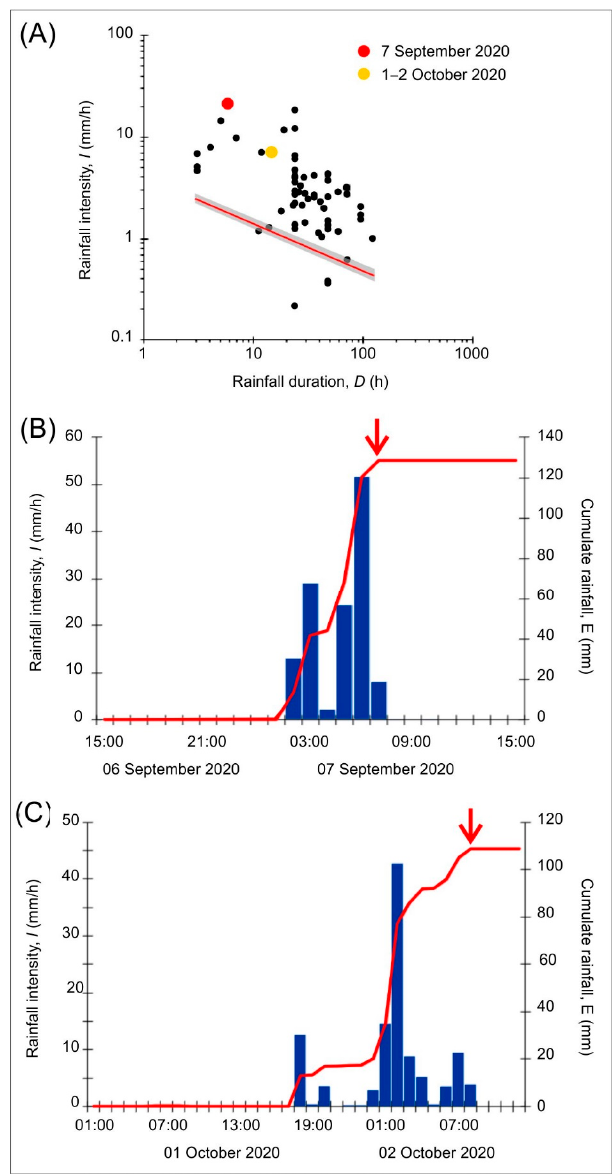
Figure 10. ( A ) Rainfall conditions (gray dots) that resulted in shallow landslides on Portofino promontory: colored dots show rainfall conditions for the 7 September 2020 (red) and the 1–2 October 2020 (yellow) events; the black line represents the 5% rainfall threshold. ( B ) Hourly rainfall (blue bars) and cumulated event rainfall (red line) for the 7 September 2020 recorded at Santa Margherita rain gauge. ( C ) Hourly rainfall (blue bars) and cumulated event rainfall (red line) for the 1–2 October 2020 recorded at Rapallo rain gauge. Red arrows identify the time of landslides occurrence (true or assumed).